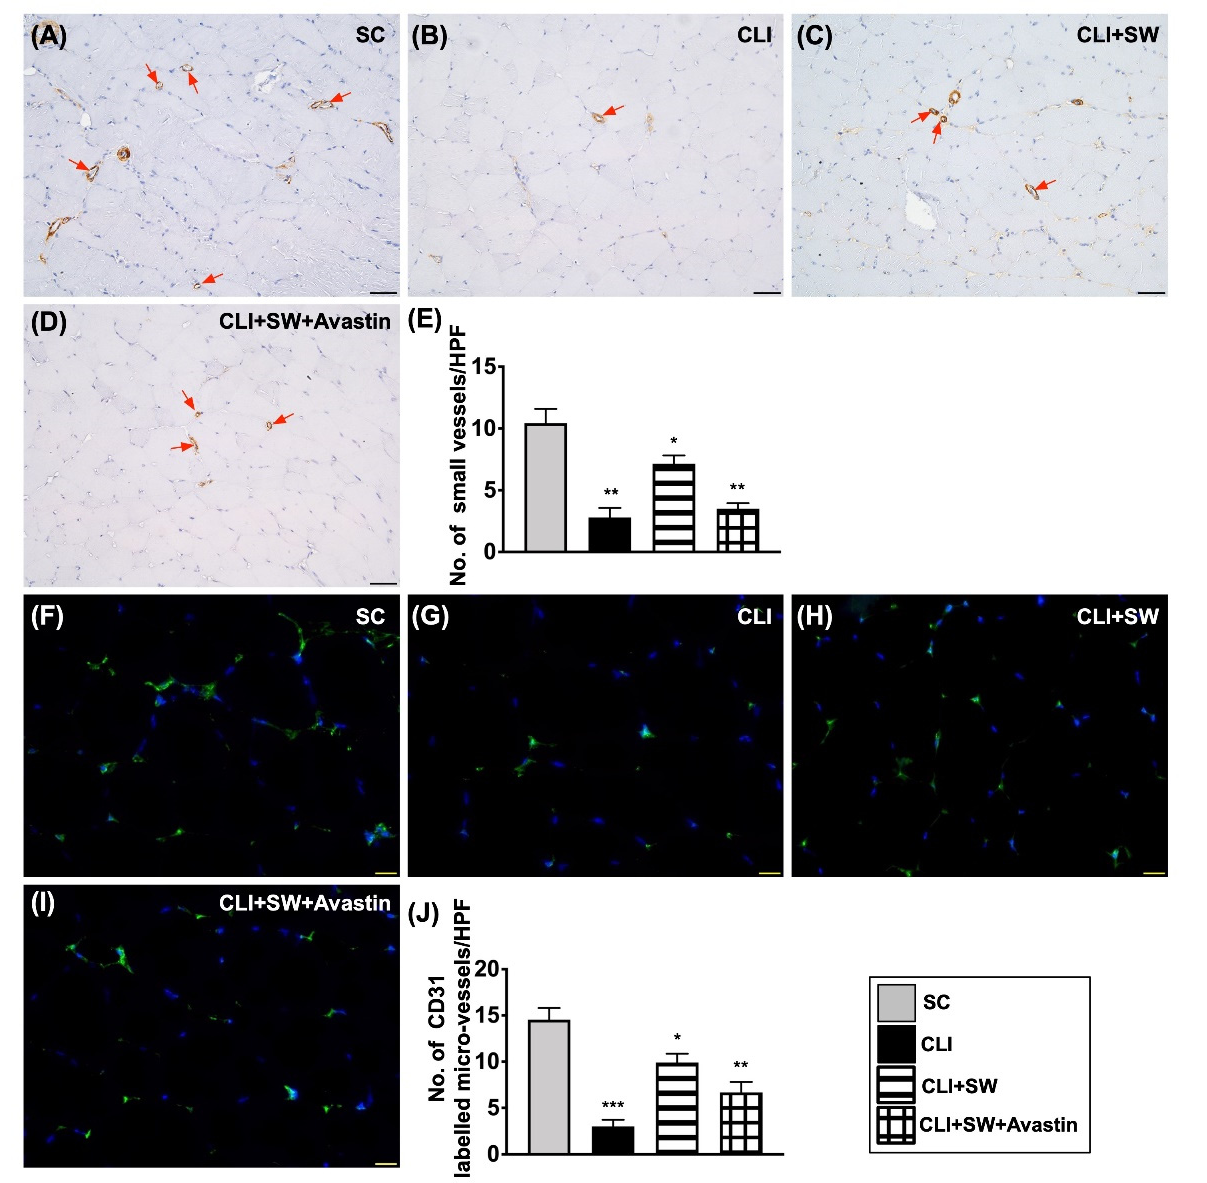
Figure 9. Small vessel density and the endothelial cell surface marker in CLI quadriceps muscle by day 14 after CLI induction. ( A – D ) Illustrating microscopic finding (200 × ) of alpha positively-stained smooth muscle actin ( α -SMA) for identifying number of small vessels (i.e., defined as diameter ≤ 25.0 µ M) (gray color) (red arrows). ( E ) Analytical result of number of small vessels, * for p < 0.05, ** for p < 0.01. All scale bars in right lower corner represent 50 µ M. ( F – I ) Illustrating the immunofluorescent microscopic finding (400 × ) for identification of CD31+ cells (green color). ( J ) Analytical result of number of CD31+ cells, * for p < 0.05, ** for p < 0.01, *** for p < 0.001. All scale bars in right lower corner represent 20 µ M. HPF = high-power field. n = 6 for each group. SC = sham-operated control; SW = shock wave.